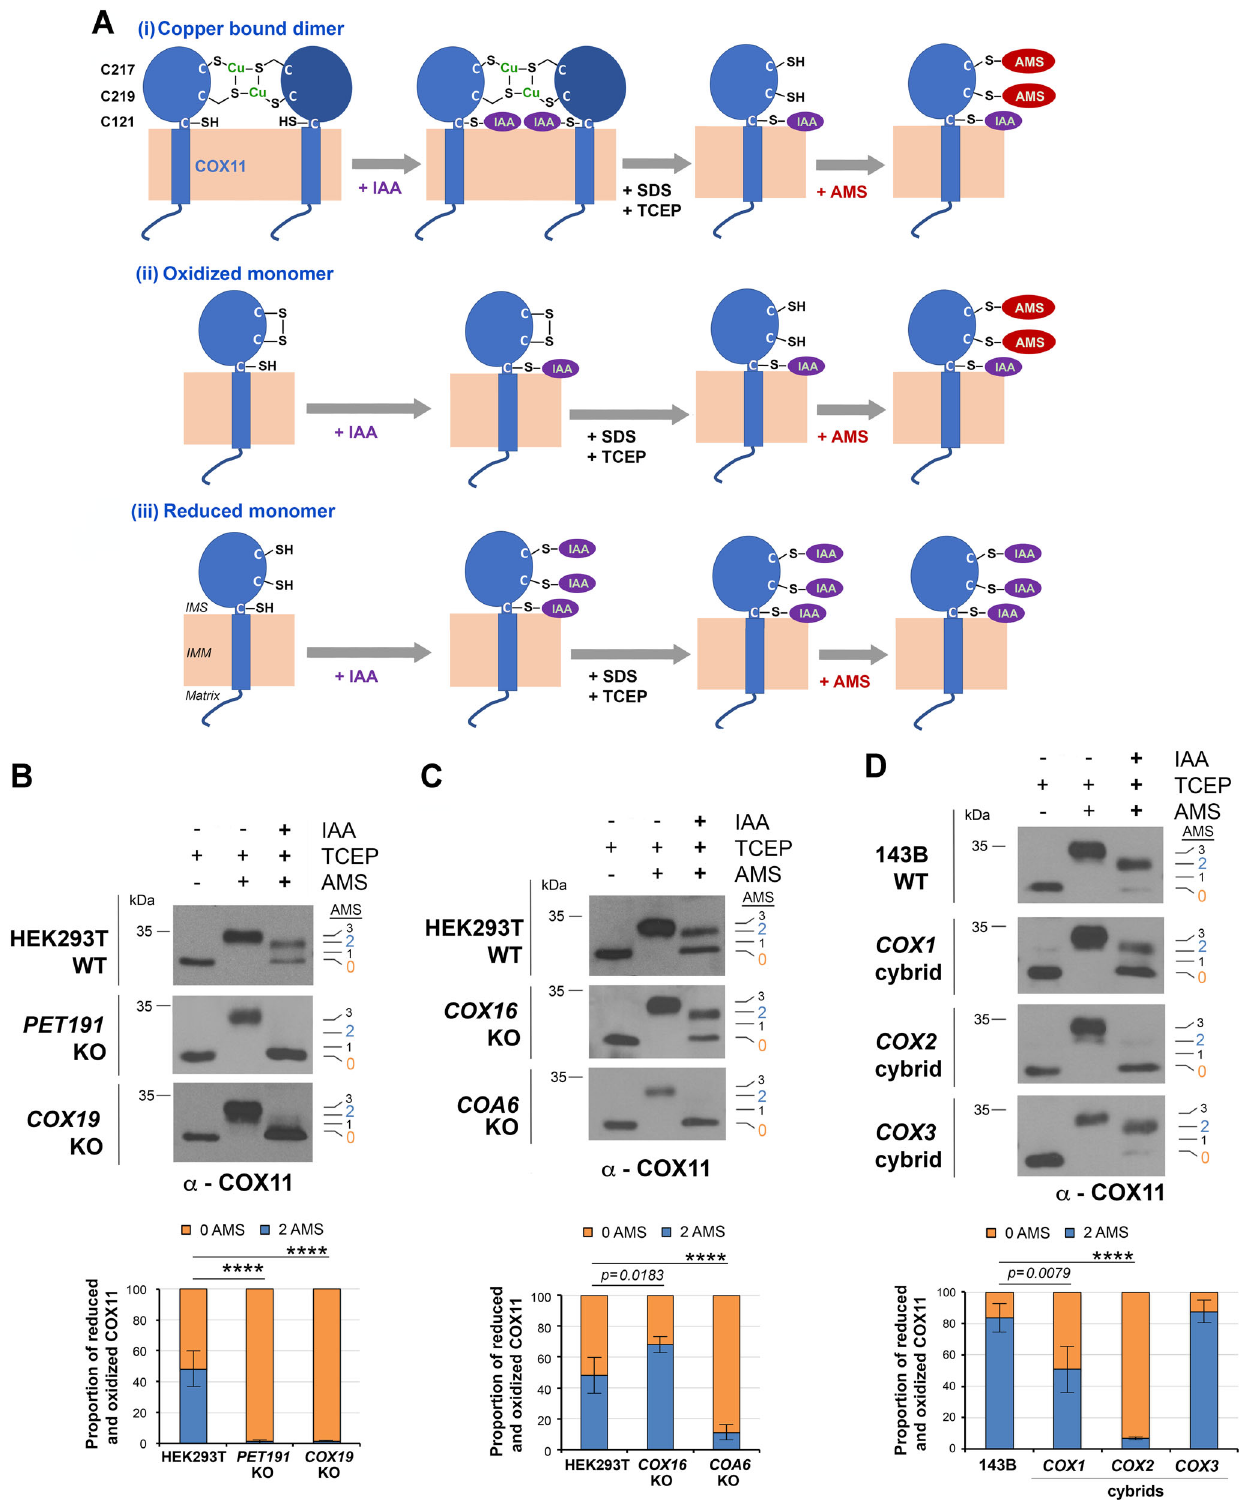
Fig. 2 COX11 redox state and copper binding are regulated by PET191 and COX19. A Reverse thiol trapping approach to detect the native cysteine residues inaccessible to a cell-permeable alkylating compound (2-iodoacetamide, IAA) that upon denaturation with SDS (sodium dodecyl sulfate) and full reduction with TCEP (tris(2-carboxyethyl)phosphine) are bound to AMS (4-acetamido-4 ’ -maleimidylstilbene-2,2 ’ - disulfonic acid), which adds ~540 Da per thiol. Three potential scenarios are depicted to account for copper (Cu)-bound COX11 dimer and oxidized or reduced COX11 monomers. B – D Reverse COX11 thiol trapping in the indicated cell lines. The bar graphs represent the average ± SD of four independent experiments. Two-sided unpaired t -test, **** p < 0.0001. Figures B – D are representative of three independent repetitions with similar results. Source data for B – D are provided as a Source Data fi le.